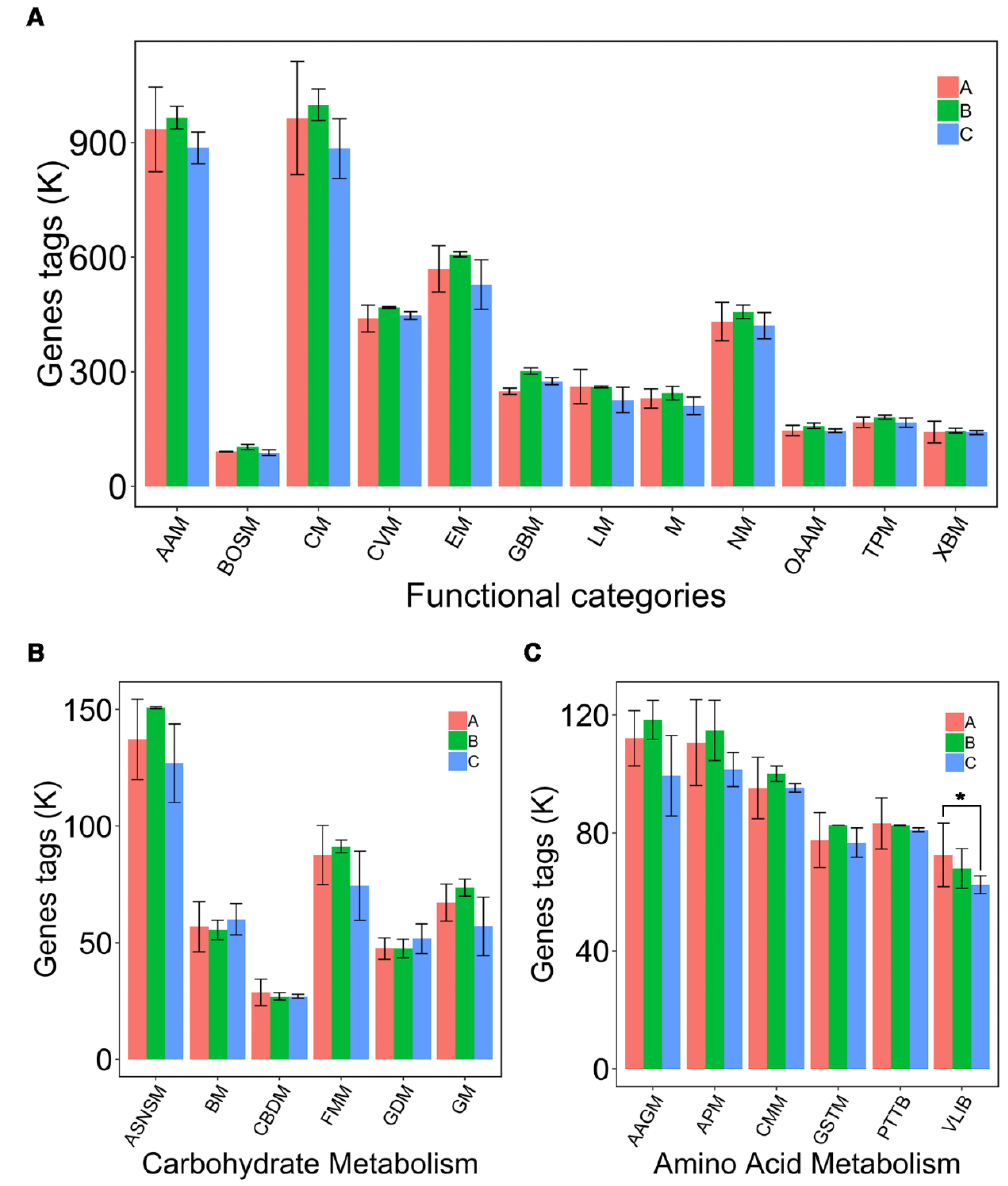
Figure 7. Prediction for Kyoto Encyclopedia of Genes and Genomes (KEGG) pathway of bacterial communities using PICRUSt program. ( A ) Prediction for metabolism of bacterial communities. AAM, amino acid metabolism; BOSM, biosynthesis of other secondary metabolites; CM, carbohydrate metabolism; CVM, metabolism of cofactors and vitamins; EM, energy metabolism; GBM, glycan biosynthesis and metabolism; LM, lipid metabolism; M, metabolism; NM, nucleotide metabolism; OAAM, metabolism of other amino acids; TPM, metabolism of terpenoids and polyketides; XBM, xenobiotics biodegradation. ( B ) Prediction for carbohydrate and amino acid metabolisms of bacterial communities. ASNSM, amino sugar and nucleotide sugar metabolism; BM, butanoate metabolism; CBDM, C5-Branched dibasic acid metabolism; FMM, fructose and mannose metabolism; GDM, glyoxylate and dicarboxylate metabolism; GM, galactose metabolism. ( C ) Prediction for amino acid metabolism of bacterial communities. AAGM, alanine, aspartate and glutamate metabolism; APM, arginine and proline metabolism; CMM, cysteine and methionine metabolism; GSTM, glycine, serine and threonine metabolism; PTTB, phenylalanine, tyrosine and tryptophan biosynthesis; VLIB, valine, leucine and isoleucine biosynthesis. * p ≤ 0.05. Group A: basal diet; group B: basal diet supplemented with antibiotics and zinc oxide; group C: basal diet supplemented with 0.06%